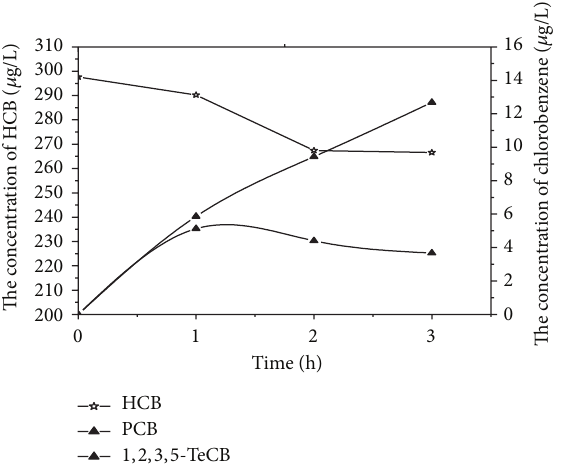
Figure 5: Variation of HCB and its dechlorination intermediates concentration using RuO 2 /Ti